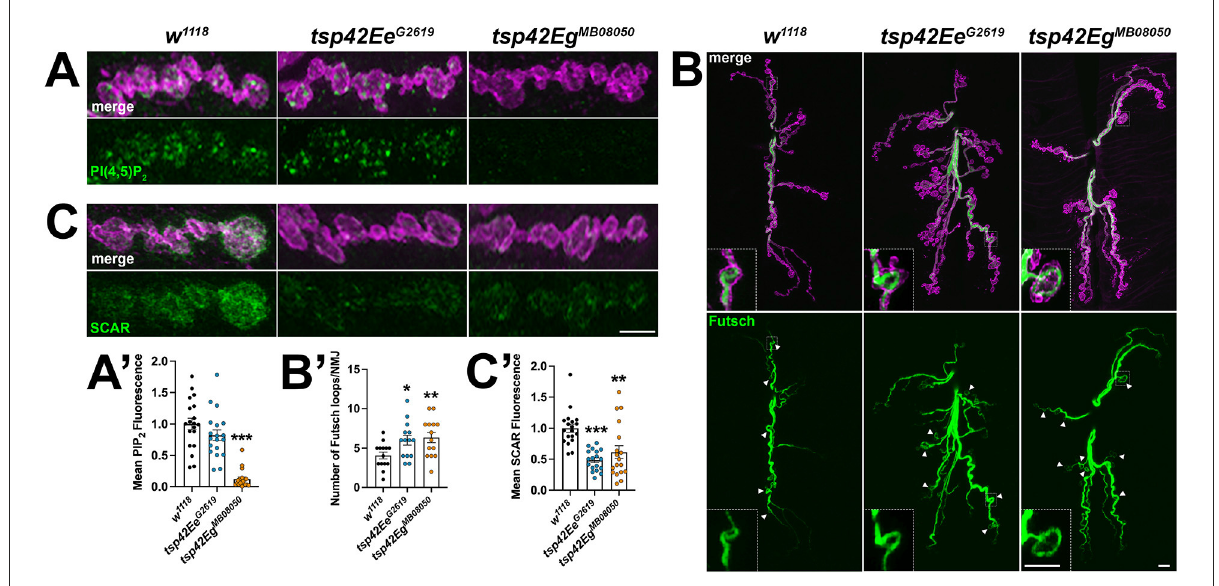
FIGURE6 Tsp42Ee and Tsp42Eg regulate synaptic membrane lipids and cytoskeletal structures. (A,C) Panels showing terminal boutons (HRP, magenta) immunolabeled for PI(4,5)P 2 (A, green) or SCAR (C, green). (A’) Quantification of mean PI(4,5)P 2 fluorescence intensity relative to w 1118